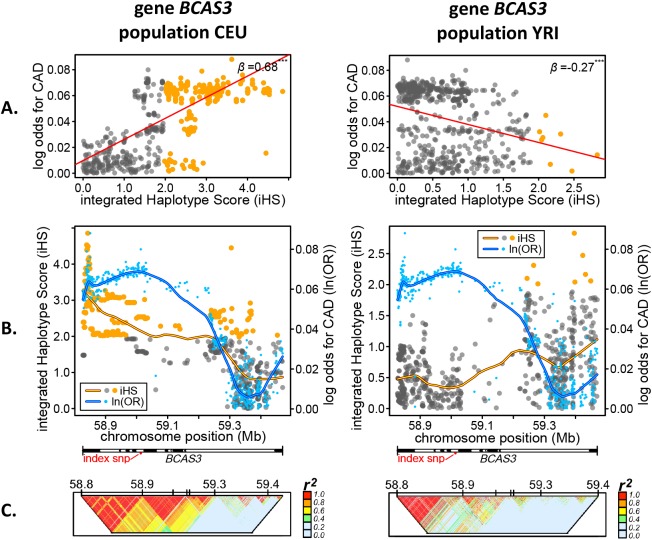
Quantitative links between coronary artery disease risk and selection signals in BCAS3.A. Correlation between selection signals (iHS) and coronary artery disease (CAD) log odds genetic risk (log odds, ln(OR)), both represented as absolute values. Red line/upper right value, β from mixed effects regression. B. Base pair positional comparison of selection signals and CAD genetic risk across BCAS3. Blue points, CAD log odds values; grey-orange or non-significant-significant points, iHS scores. Horizontal bar shows BCAS3 gene (and intron) span and location of lead index SNP. Blue/orange lines are smoothed lines estimated with loess function in R. C. LD plots, r2. Populations: CEU, Utah residents with ancestry from northern and western Europe from the CEPH collection; YRI, Yoruba from Ibadan, Nigeria.